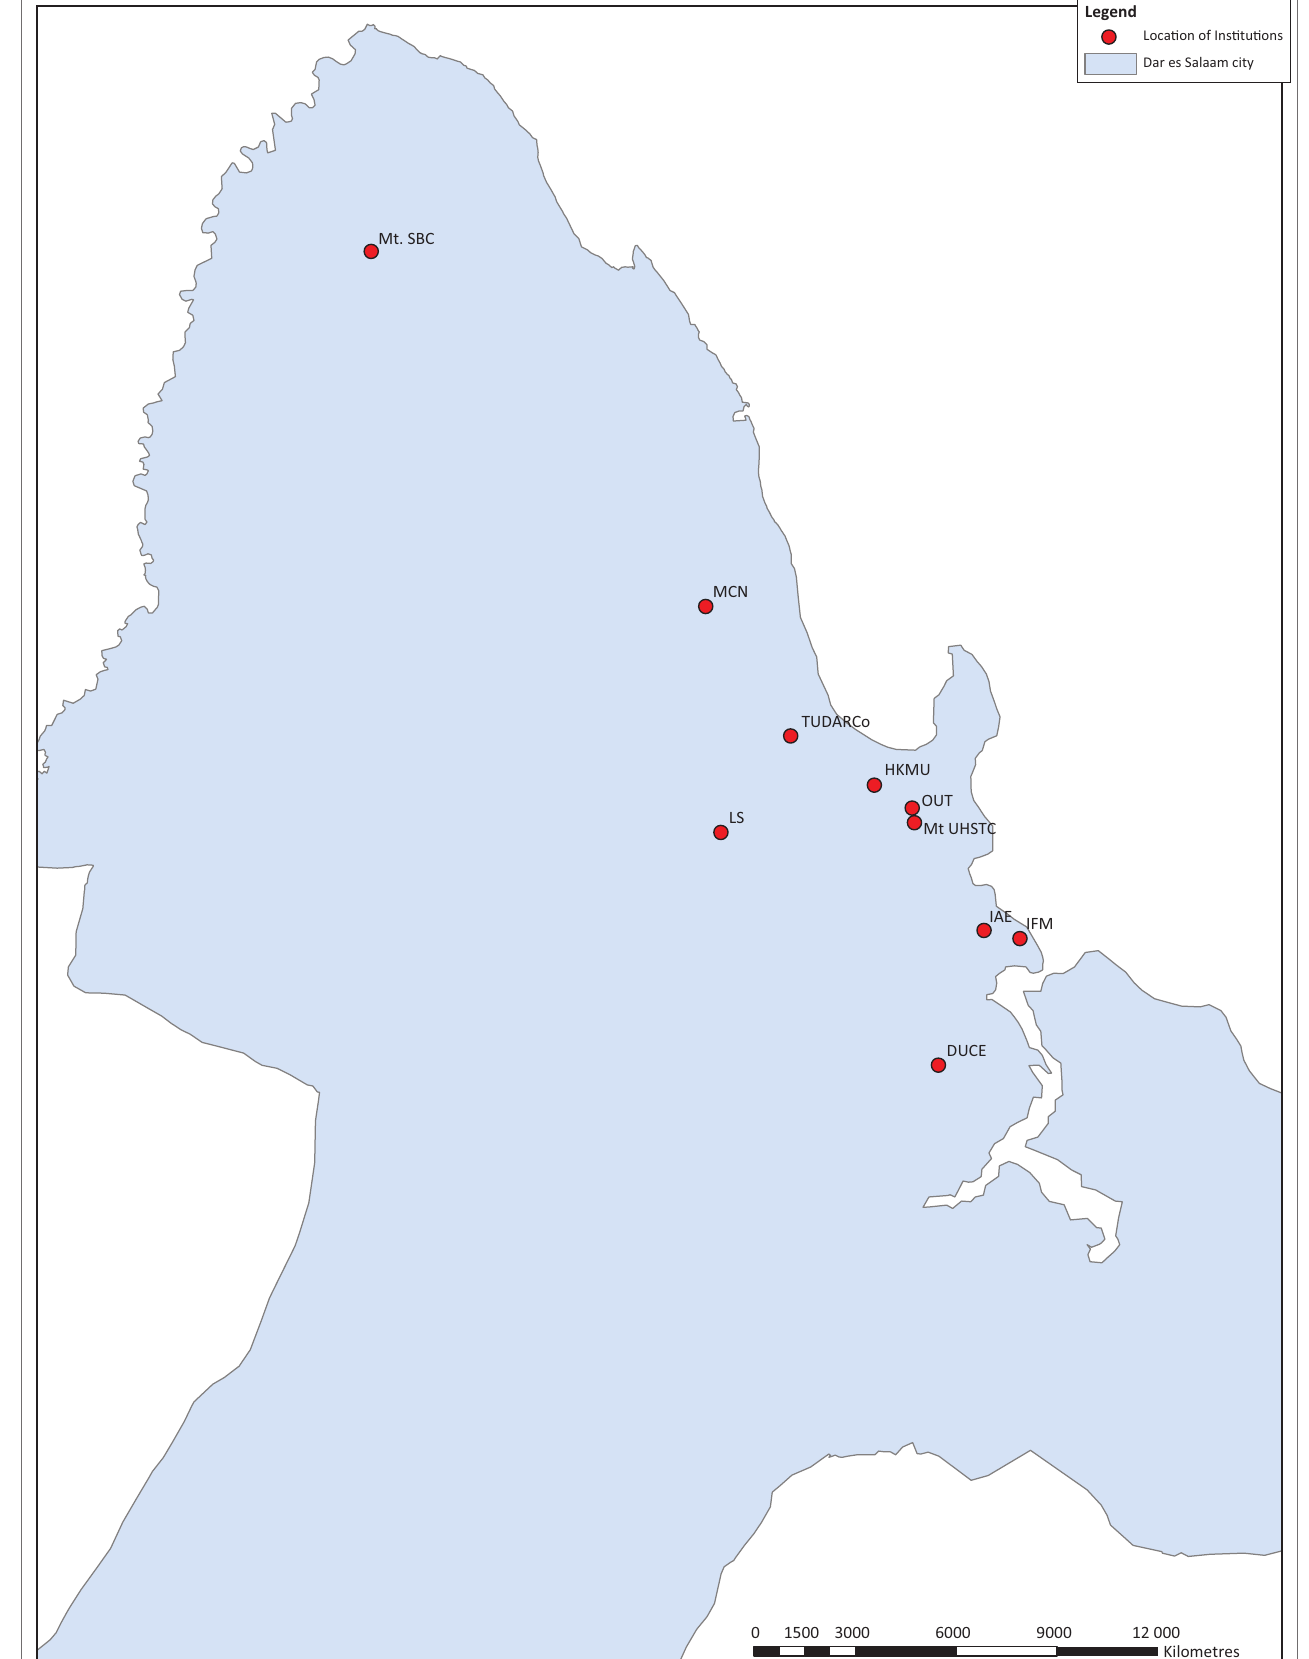
FIGURE 1: Location of the institutions under